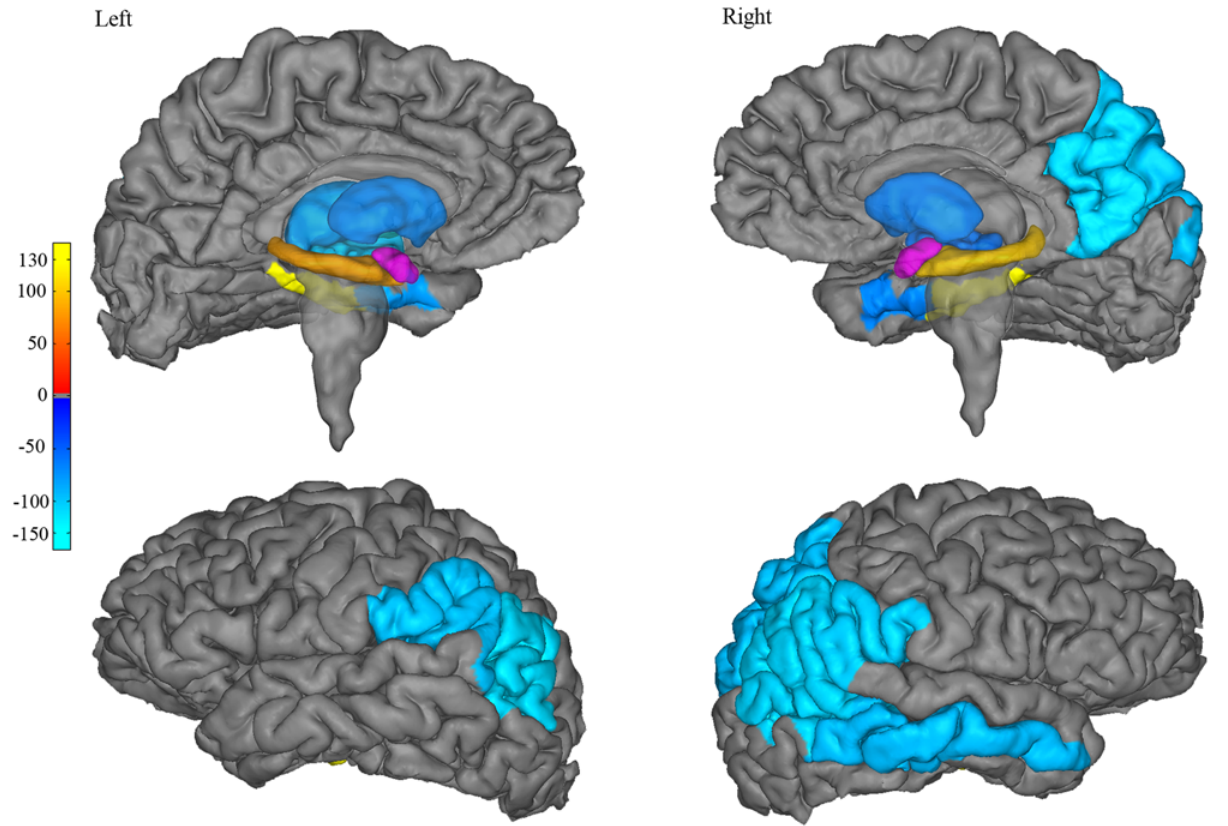
Fig 5. Changes in connectivity with age. The weight, or contribution, of each target region in the final model of age by amygdala connectivity, are displayed. Negative weights represent decreasing connectivity with age, and range from dark-blue (corresponding to lower absolute weights in the model) to light-blue (higher absolute weights). Positive weights (increasing connectivity with age) are illustrated by the red- (low weights) to-yellow (high weights) colors. Right and left amygdalae are depicted in purple.